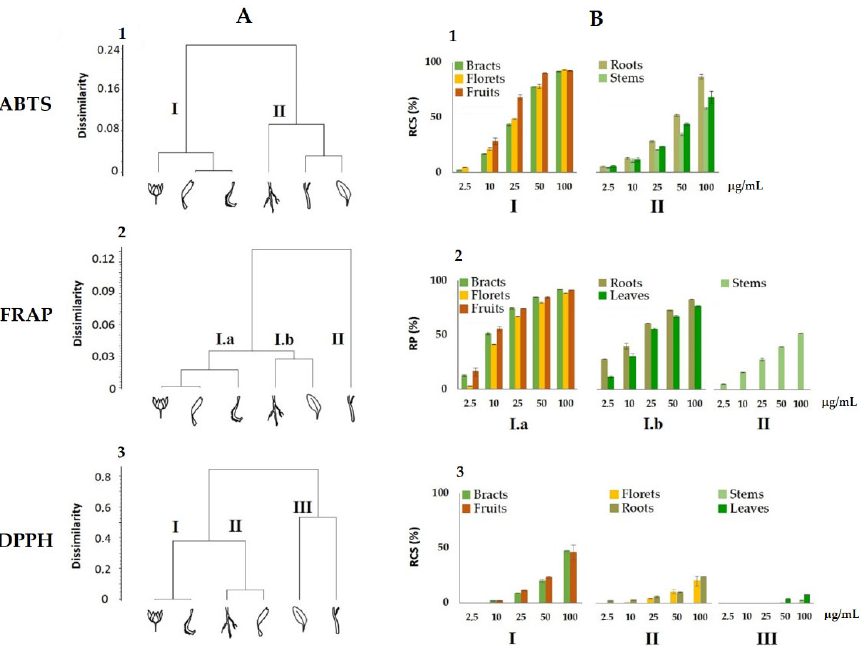
Figure 5. Dendrograms ( A ) and activity ( B ) from antioxidant assays (ABTS, PFRAP, and DPPH) carried out on the alcoholic extracts of the Calendula arvensis organs. RSC, Radical Scavenging Capacity; RP, Reducing Power. Data are expressed as the mean ± SD of two experiments, independently carried out, each of which in triplicate.